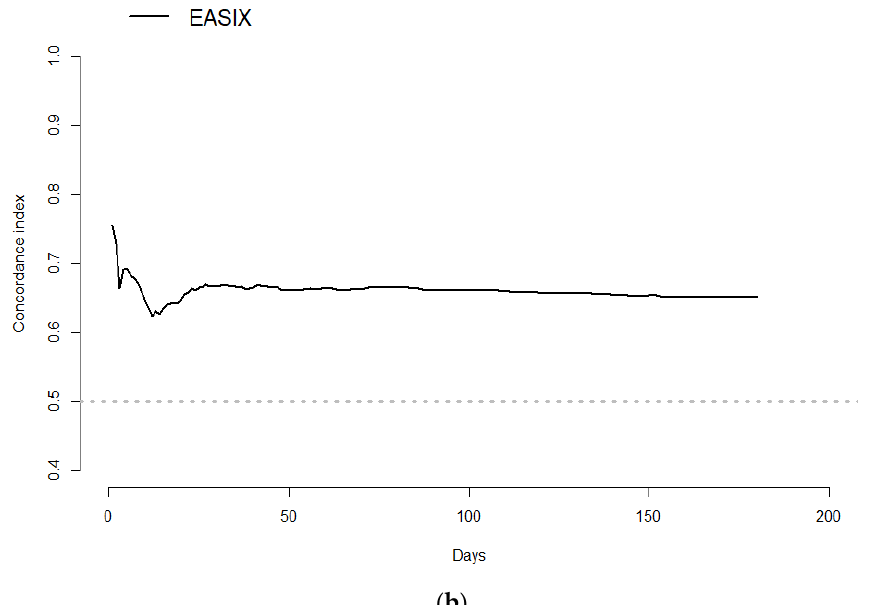
Figure 6. Prediction error curve for overall survival. Prediction error for the validation of the predictive impact of log2EASIX on survival. Black line: reference model (null model). Red line below the reference indicates model validation. Survival (time = 180 days): Reference = 0.187, log2EASIX = 0.16.( a ); Concordance index for overall survival. Black line: reference model (null model). Survival (time = 180 days): Reference = 0.187, log2EASIX = 0.16.( b )